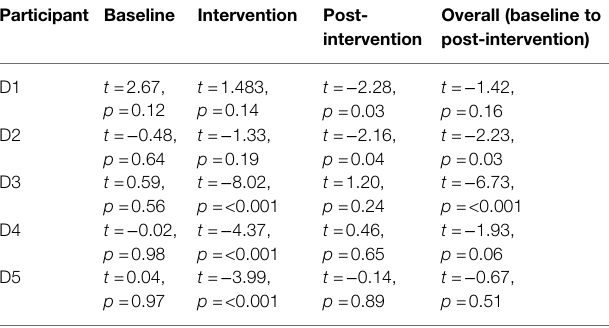
TABLE 4 | Time-seri es analysis results for participants D1–D5 using MindShift . Participant Baseline Intervention Post-